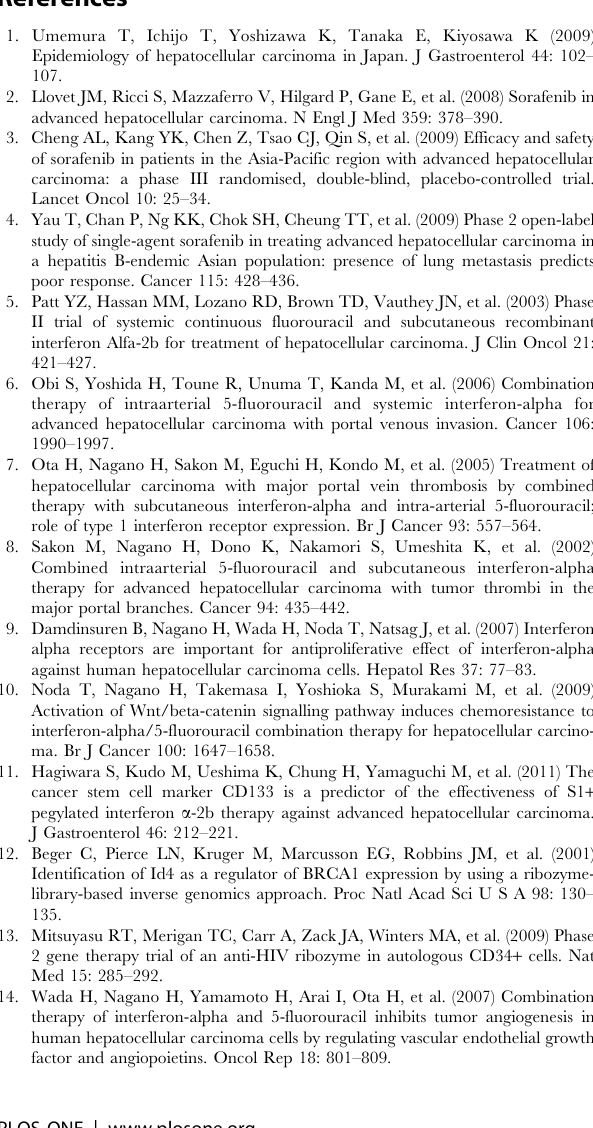
ribozyme library, and plasmid DNAs recovered after ten cycles of screening were analyzed by using the BLAST. The numbers of colonies, whose sequences target the same gene, were shown. Table S3 Univariate analysis of factors associated with outcome. Statistical analysis was performed using log rank test. * P , 0.05. Each parameter was divided into two categories according to the median line. File S1 Supporting Materials and Methods used in the